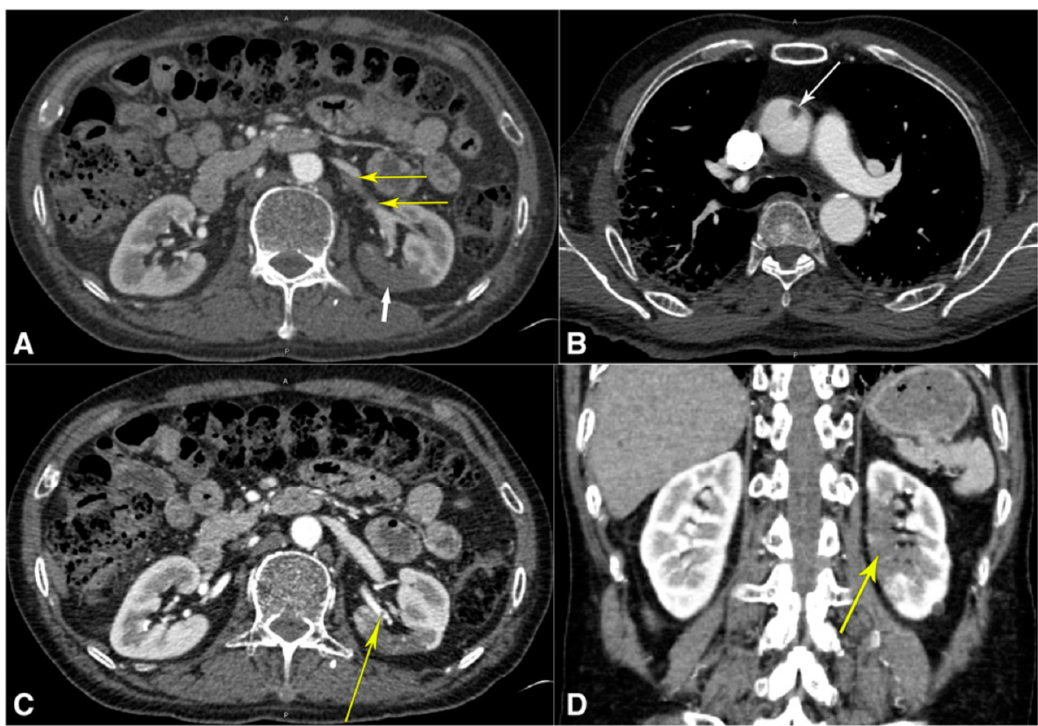
Figure 8. Tomography computed using angiography: ( A ) abdominal computed tomography angiography (CTA), demonstrating thrombi in the left superior renal artery (thin yellow arrows) and infarcts in the posterior mid-pole of the left kidney (thick white arrow); ( B ) CTA of the thorax, demonstrating ascending aortic thrombus (arrow); ( C ) abdominal CTA displaying a different perspective of the left superior renal artery thrombus (yellow arrow); ( D ) computed tomography abdominal angiography in coronal projection, demonstrating the extent of the left renal infarction (yellow arrow). This image is presented in color at www.ajmh.org (accessed on 28 March 2020). Mukherjee et al. [121] .